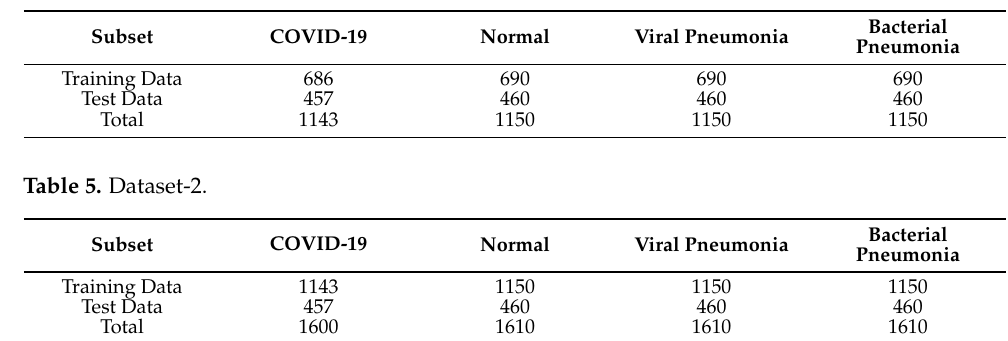
Figure 4. Sample chest X-ray of COVID-19, normal, viral pneumonia, bacterial pneumonia and adult pneumonia cases. Table 4. Dataset-1.